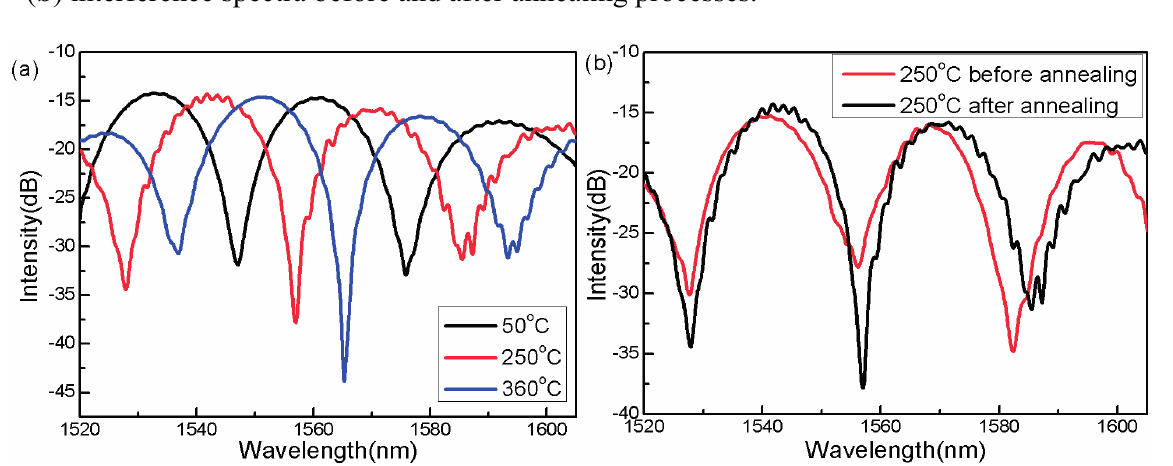
( b ) interference spectra before and after annealing